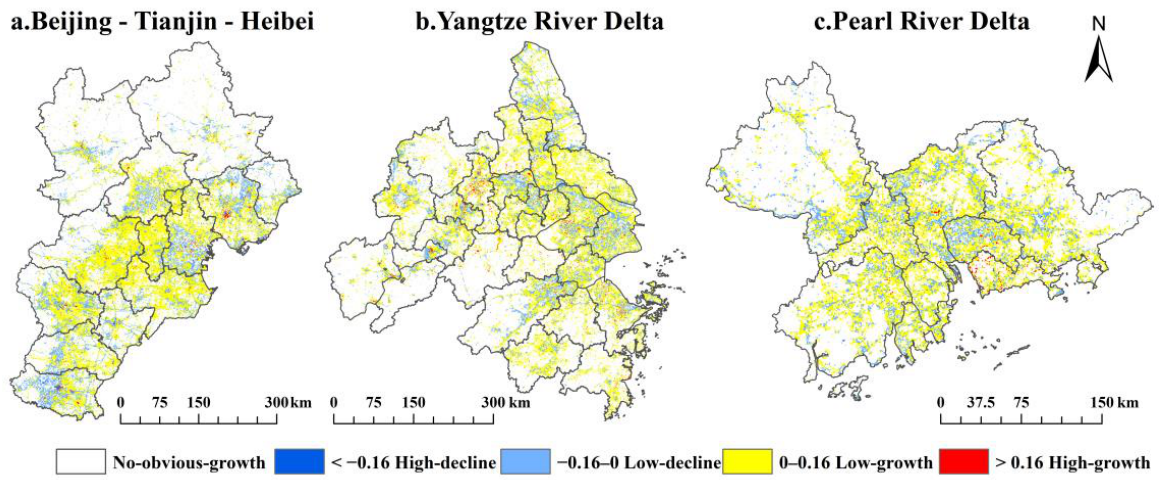
Figure 7. Temporal trends of CO 2 emissions in three urban agglomerations from 2014 to 2019. The white area was not passed the significance test ( p > 0.05). High-decline: S slope < − 0.16; Low-decline: − 0.16 < S slope < 0; Low-growth: 0 < S slope < 0.16; High-growth: 0.16 < S slope .